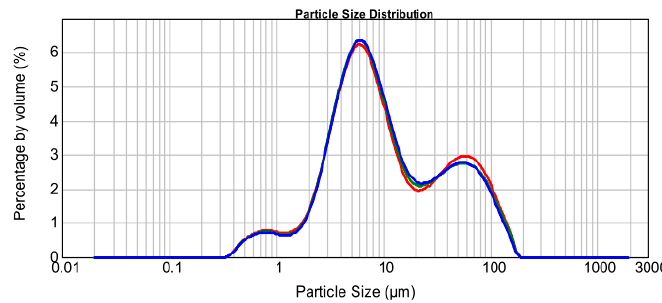
Table 4. Analysis of particle composition of manganese slag.